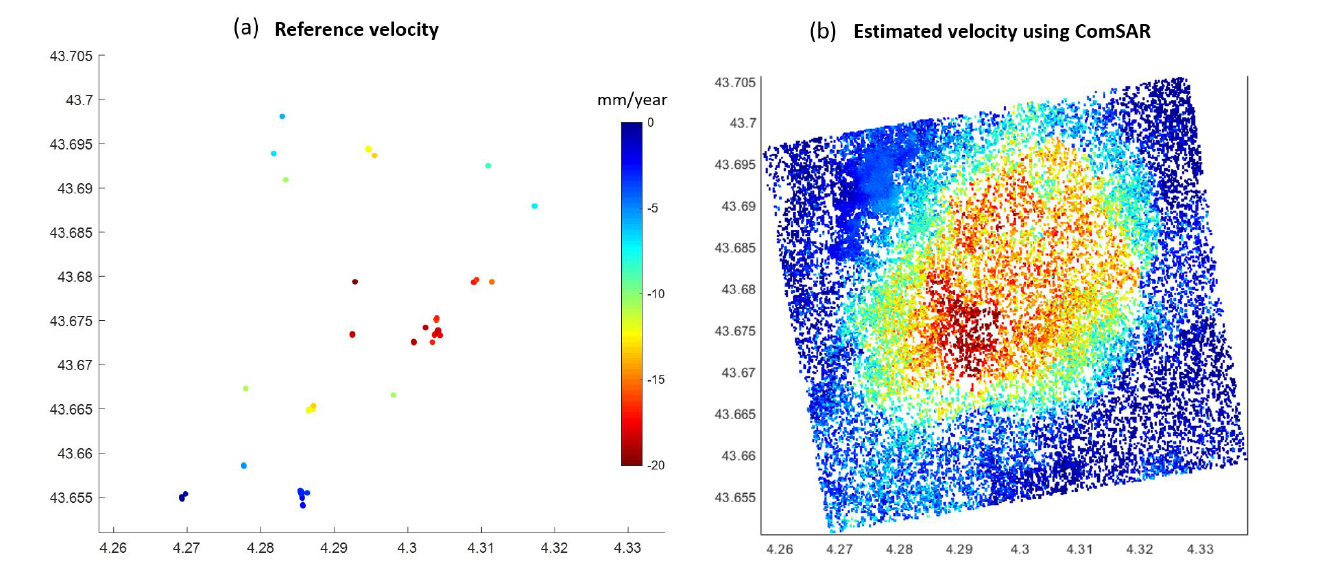
Figure 7. Velocities with coordination associated. ( a ) reference velocity in mm/year; ( b ) estimated velocity using ComSAR. A circle-shaped subsidence zone is visible with a 5 km diameter and subsidence up to 20 mm/year.